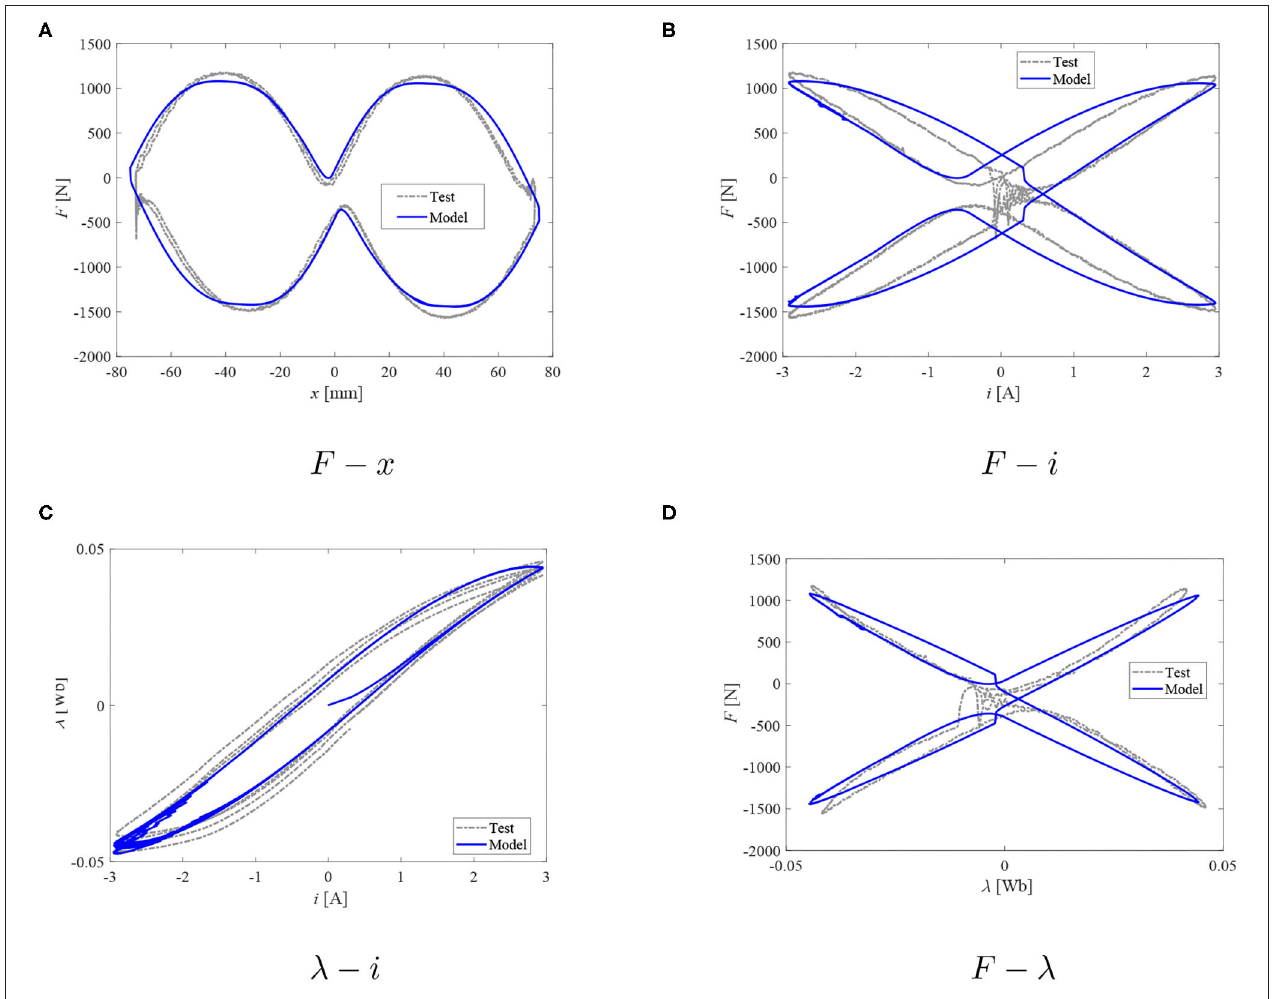
FIGURE 12 | Damper model: measured force and reconstructed flux vs. model data; I = 3.0 A. (A) F − x . (B) F − i . (C) λ − i . (D) F − λ